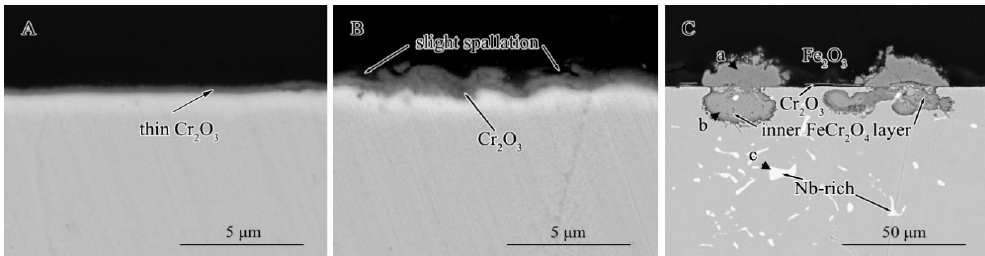
Figure 6. Cross-sectional morphologies of the three groups of alloys after oxidation in pure water